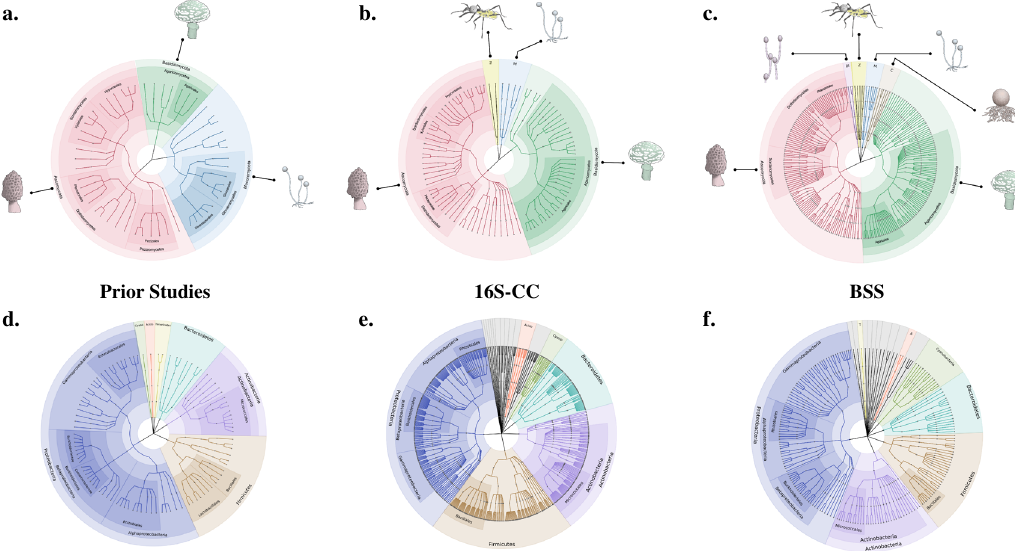
Fig. 2 Expanded taxonomic diversity of bacterial – fungal associations. Prior fi ndings of bacterial – fungal associations were compared with both the 16S-CC and BSS screens completed in this study. The upper panel presents the taxonomic diversity of fungal hosts examined in a prior studies, b the culture collections included in the 16S-CC screen, and c the fungal genome projects used in the BSS screen. The lower panel displays the corresponding taxonomic diversity of bacteria associated with these fungi, observed in d prior studies, e the 16S-CC screen, and f the BSS screen. Terminal nodes represent distinct genera and edges are colored by phyla. Abbreviations for the fungal hosts: M Mucoromycota, Z Zoopagomycota, Bl Blastocladiomycota, C Chytridiomycota. Abbreviations for the bacterial associates: Acido/A Acidobacteria, Cyano Cyanobacteria, T Tenericutes). Several bacterial phyla not previously described as fungal associates, but identi fi ed in our 16S-CC and the BSS screens are represented in gray (Aqui fi cae, Armatimonadetes, Calditrichaeota, Chlamydiae, Chloro fl exi, Deinococcus-Thermus, Fibrobacteres, Fusobacteria, Gemmatimonadetes, Nitrospirae, Planctomycetes, Rhodothermaeota, Spirochaetes, Synergistetes, Thermodesulfobacteria, Thermotogae, and